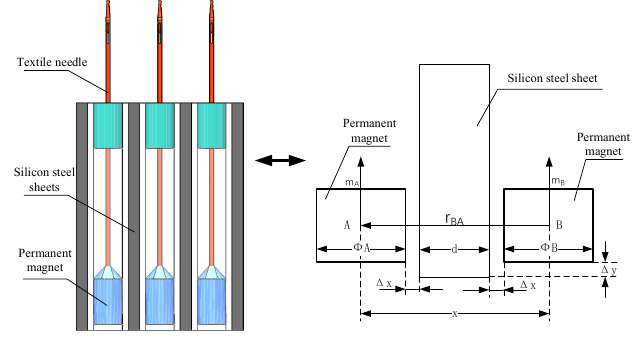
Figure 4. Simplified model of silicon steel magnetic isolation.